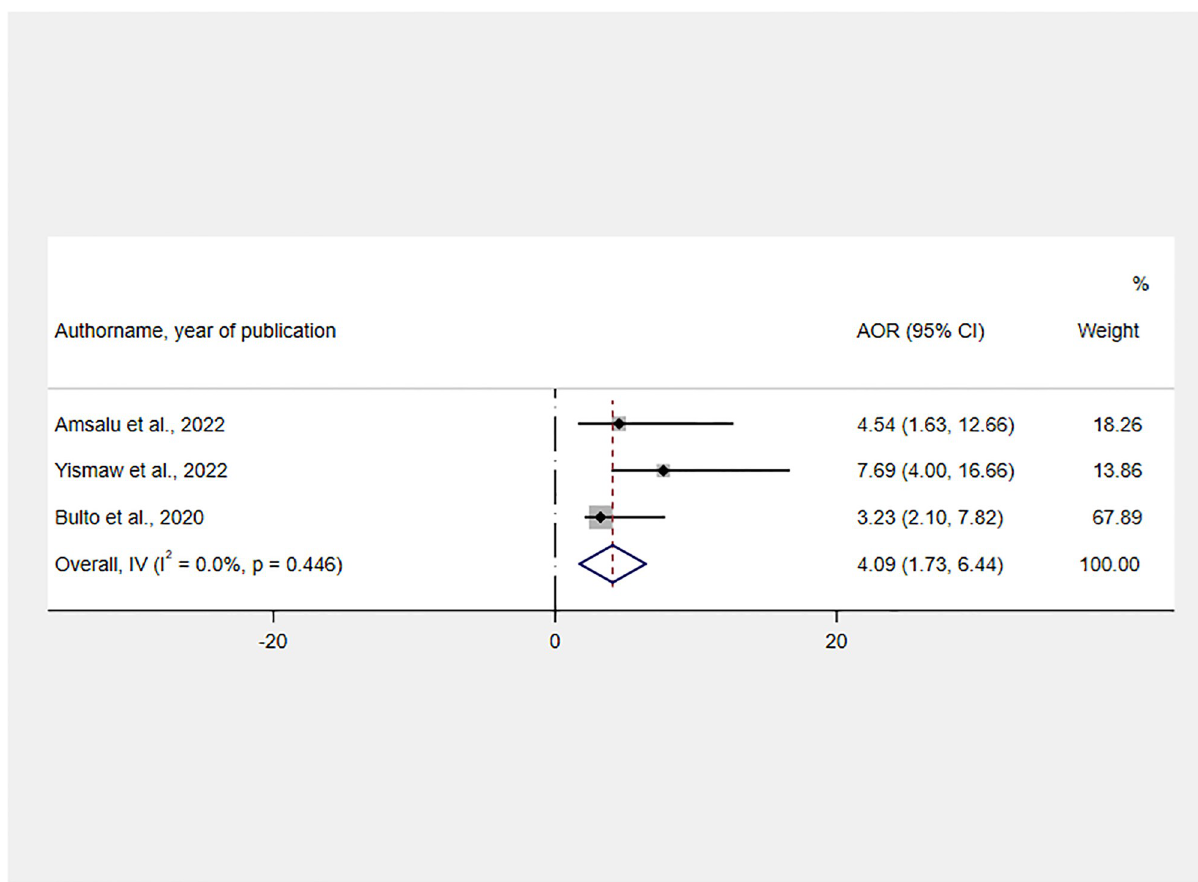
Fig 7. Forest plot showing the association between service delivered by CRC-trained healthcare providers and RMC in Ethiopia, 2022.